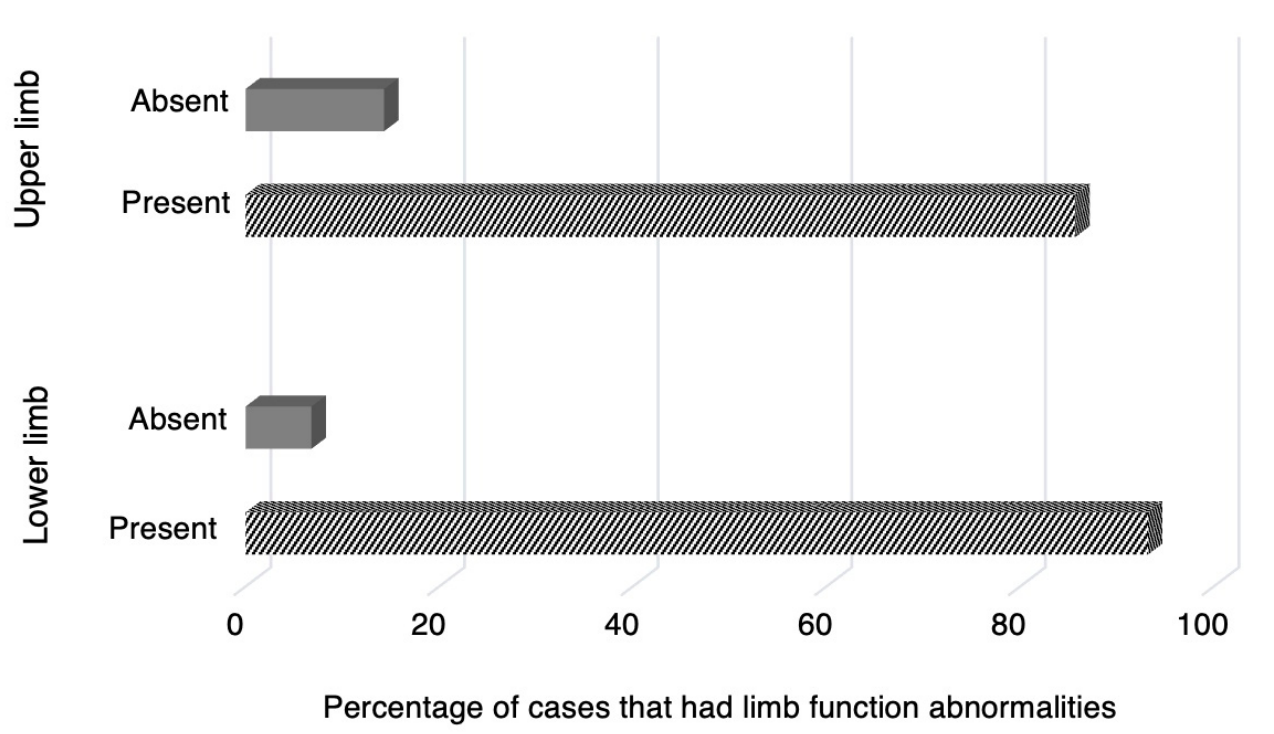
Figure 3. Percentage of cases with limb function abnormalities.